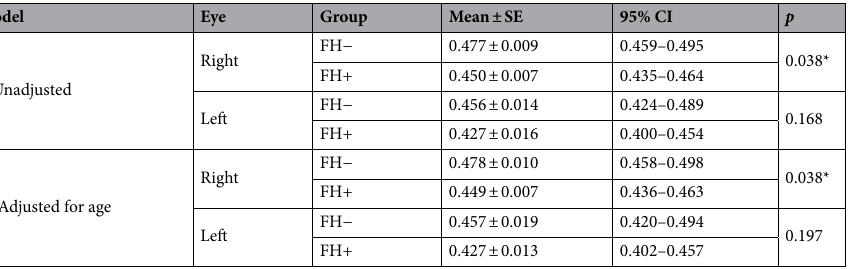
Table 3. Difference in Pupil Response Latency (PRL) between groups at targets with highest weights given by the machine-learning algorithm. Data are presented as the mean ± standard error (SE), and 95% confidence interval (CI) of the pupil response latency (PRL) in seconds recorded in each group in the right eye in the two discriminative visual field targets and the left eye in the discriminative visual field target (see Fig. 2). *p < 0.05 following Bonferroni